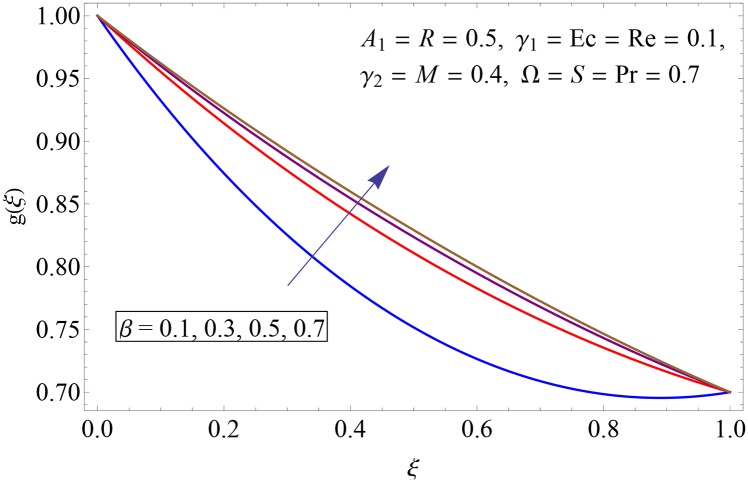
Impact of β on g(ξ).